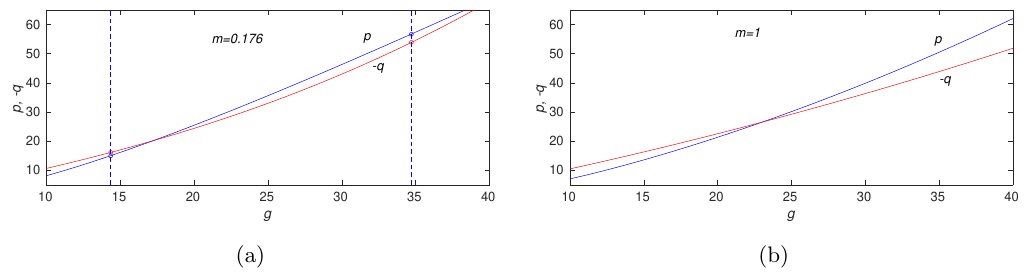
Figure 9 . Scalar dipole moment p and vector monopole charge q of a 1-Skyrmion as a function of coupling g for pion mass (a) m = 0 : 176, and (b) m = 1. The dashed lines on (a) mark the coupling values studied in detail via scattering